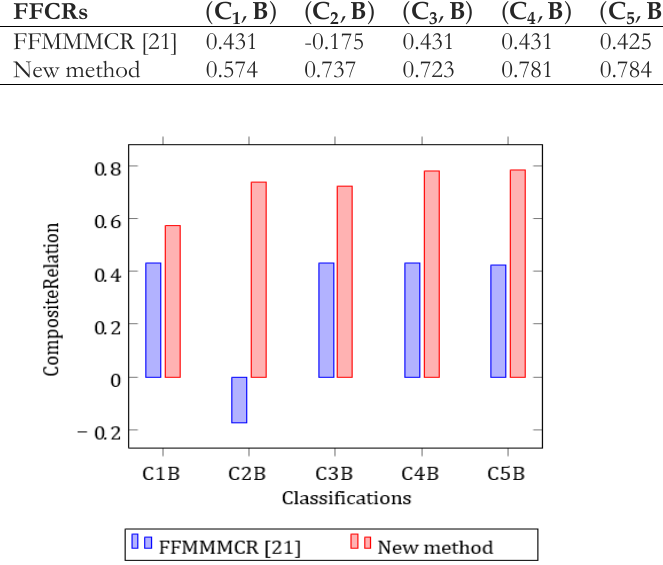
Fig. 3. Graphical representation of FFCRs for problem